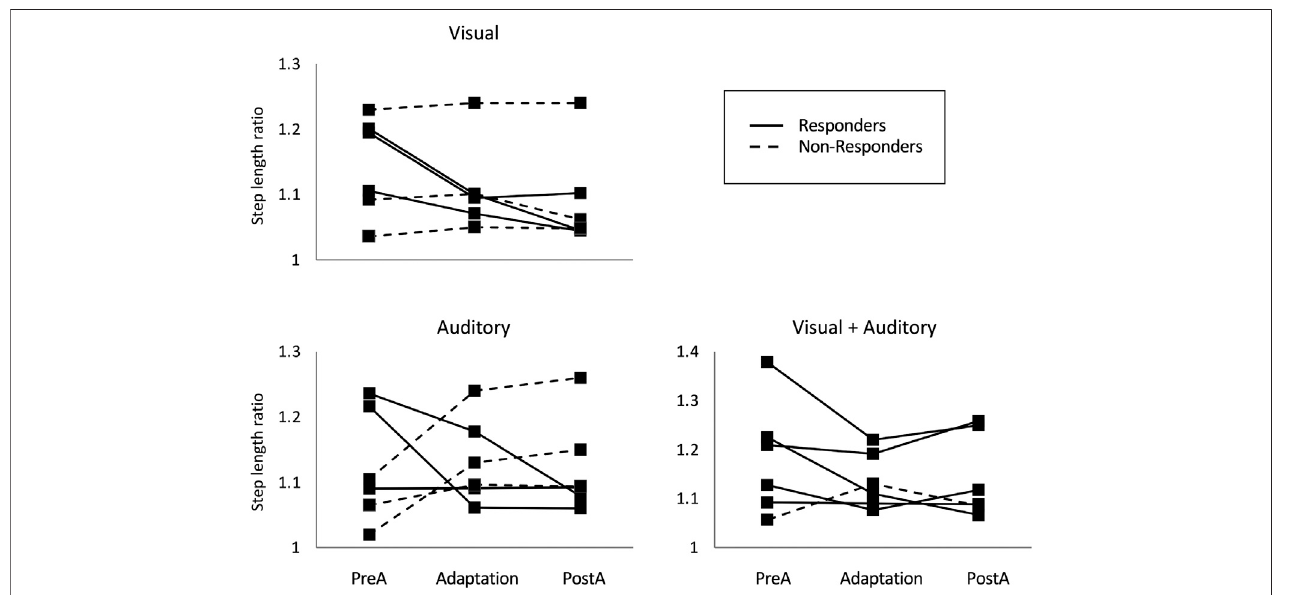
FIGURE 3| Step length ratio values exhibited bystroke survivors walking on a self-paced treadmill while exposed toavatar-based feedback in the visual, auditory, and combined (visual + auditory) sensory modality. Values are presented for the preadaptation (no avatar for 30 s), adaptation (avatar present for 1 min), and postadaptation periods (avatar removed for 1 min). Responders, that is individuals showing a reduction of their step length ratio during the adaptation period, are represented by a plain line, while non-responders are represented by a dotted line. Note the larger number of responders to the combined vs. individual sensory